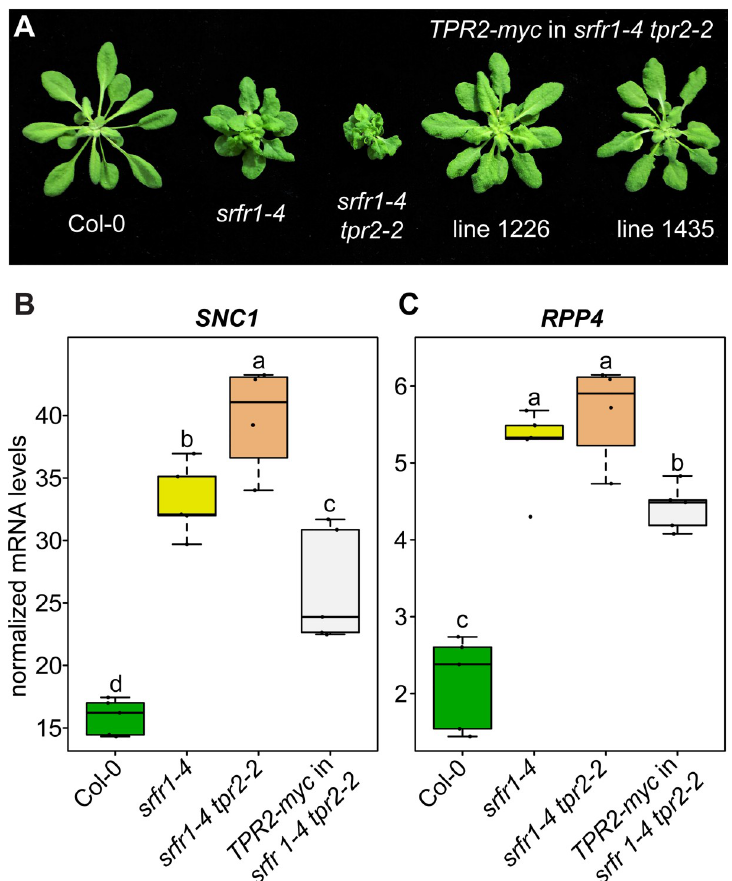
Fig 5. Overexpression of TPR2 reduces stunting and SNC1 expression in srfr1 tpr2 . (A) Morphological phenotype of TPR2-myc srfr1-4 tpr2-2 compared to srfr1-4 and srfr1-4 tpr2-2 . Plants were grown under short day conditions at 21˚C for four weeks. (B&C) Expression as measured by quantitative RT-PCR of SNC1 and RPP4 . Dots represent individual data points taken over two separate experiments. Genes of interest were normalized against SAND (At2g28390). Whiskers on boxplots are drawn to the farthest data point within 1.5 � IQR of first and third quartiles. Letters denote significant differences as determined by Student’s t-test ( P < 0.05) using the Bonferroni-Holm method to correct for multiple